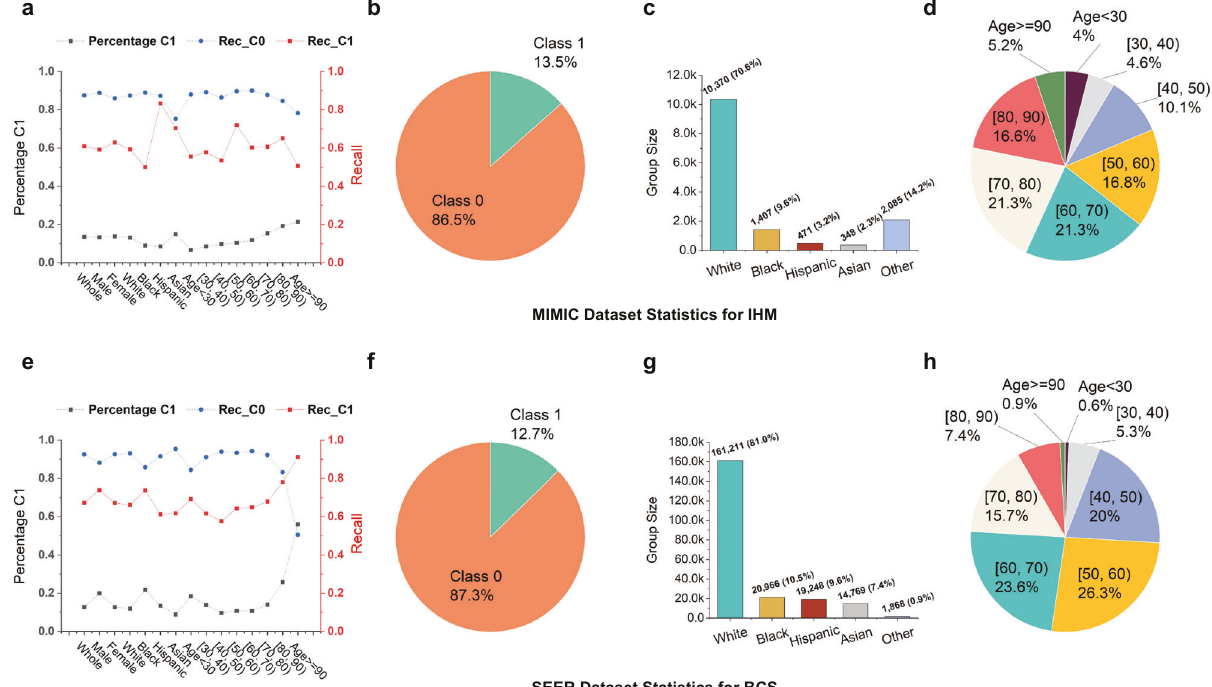
Fig. 2 Recall values for both classes C0 and C1 and training data statistics for the in-hospital mortality (IHM) and the 5-year breast cancer survivability (BCS) tasks. a Percentage of the minority class C1, Recall C0, and Recall C1 of each subgroup of the MIMIC dataset for the IHM task. Statistics of b prediction class distribution, c racial group distribution, and d age group distribution for the MIMIC IHM dataset. The MIMIC IHM training set consists of 45.1% female samples and 54.8% male samples. e Percentage of the minority class C1, Recall C0, and Recall C1 of each subgroup of the SEER dataset for the BCS task. Statistics of f prediction class distribution, g racial group distribution, and h age group distribution for the SEER BCS dataset. The SEER BCS training set consists of 99.4% female samples and 0.6% male